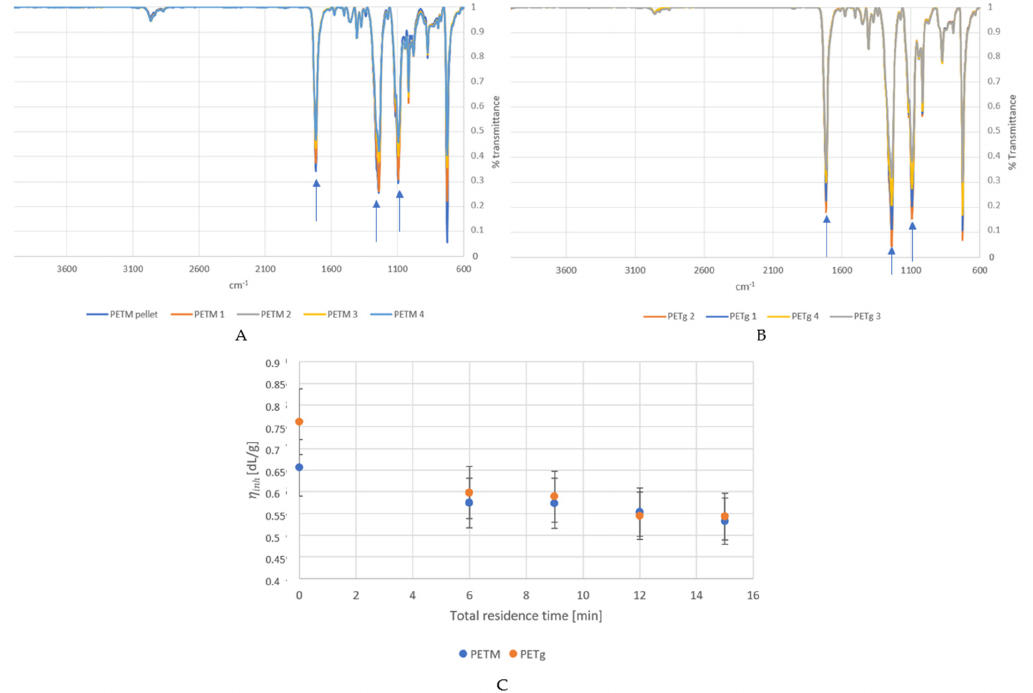
Figure 3. FTIR spectra for the virgin PETM ( A ) and PETg ( B ) (top curves) samples and residence time samples with various total residence times (see Table 1). Arrows are pointing at the increasing intensity of the C=O stretching vibration band ν C=O,st = 1716 cm − 1 relative to the C-O-C stretching band ν C-O-C,st = 1240 and 1093 cm − 1 . ( C ) Inherent viscosity η inh of the PETM and PETg residence time samples (see Table 1) vs. total residence